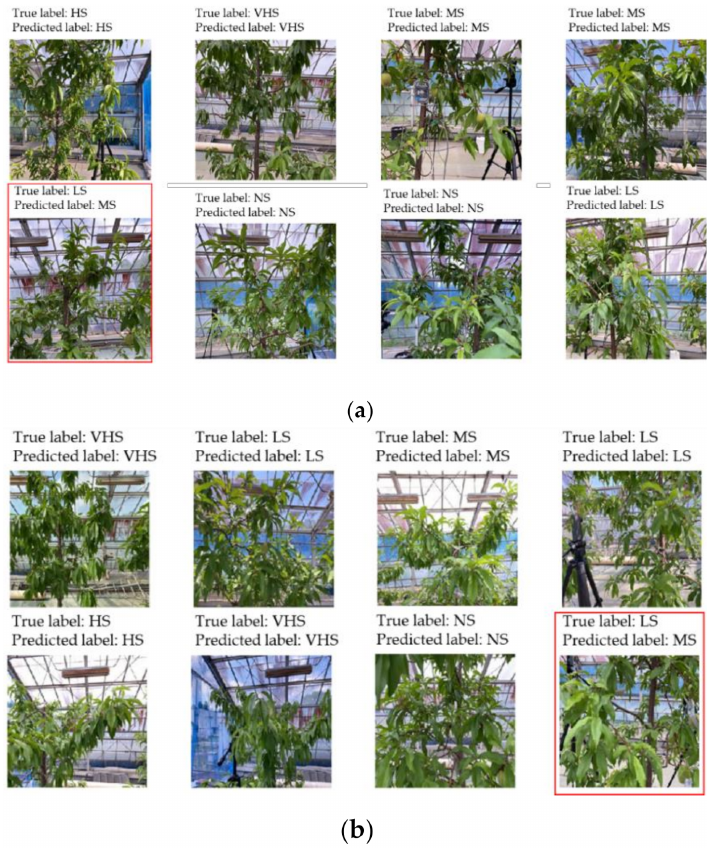
Figure 9. Prediction based on validation ( a ) and test ( b ) image datasets.